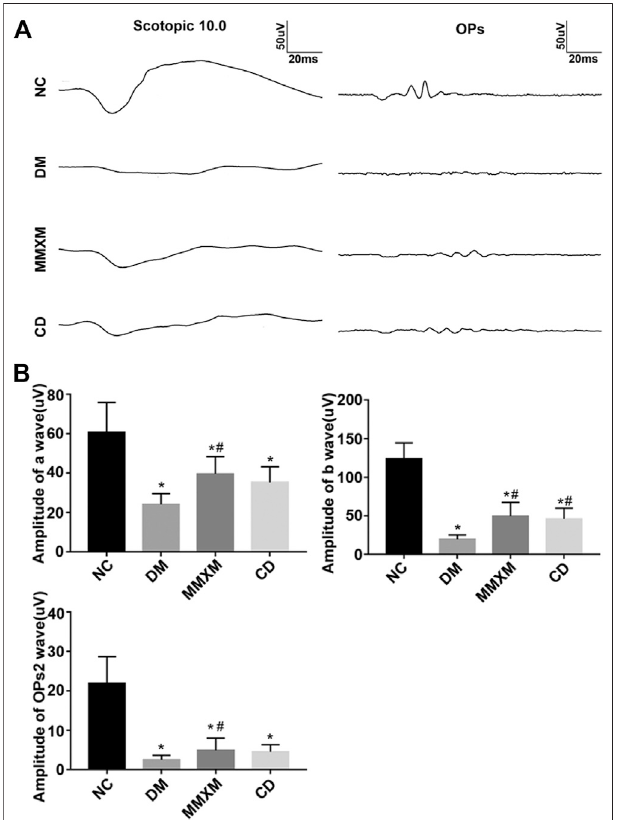
FIGURE5|(A) TypicalscotopicERGtraces. (B) Theamplitudestatistics of a, b, and OPs2 waves. Values are presented as mean ± SD.* p < 0.05 vs. NC; # p < 0.05 vs.